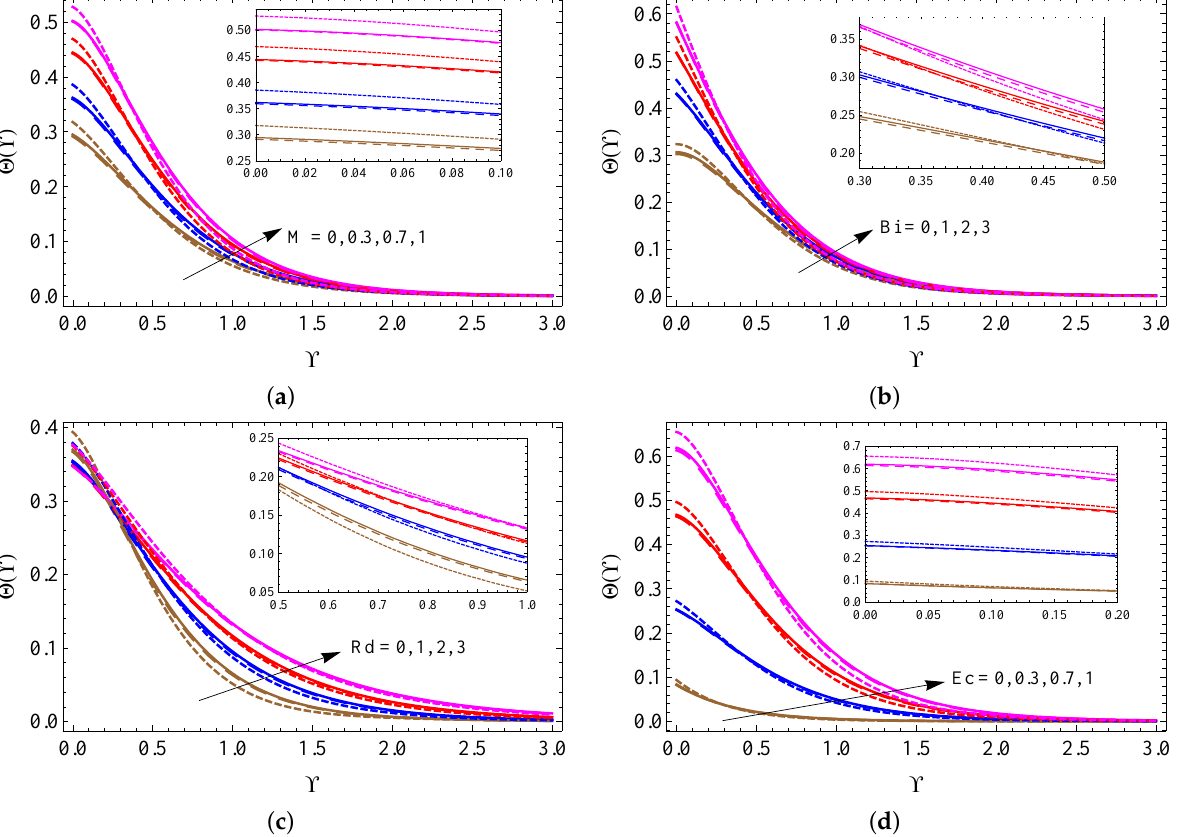
Figure 5. The contrast of Θ ( Υ ) against M ( a ), Bi ( b ), Rd ( c ) and Ec ( d ) for SWCNTs (solid line), MWCNTs (dashed line) and Al 2 O 3 nanofluid (dotted line).